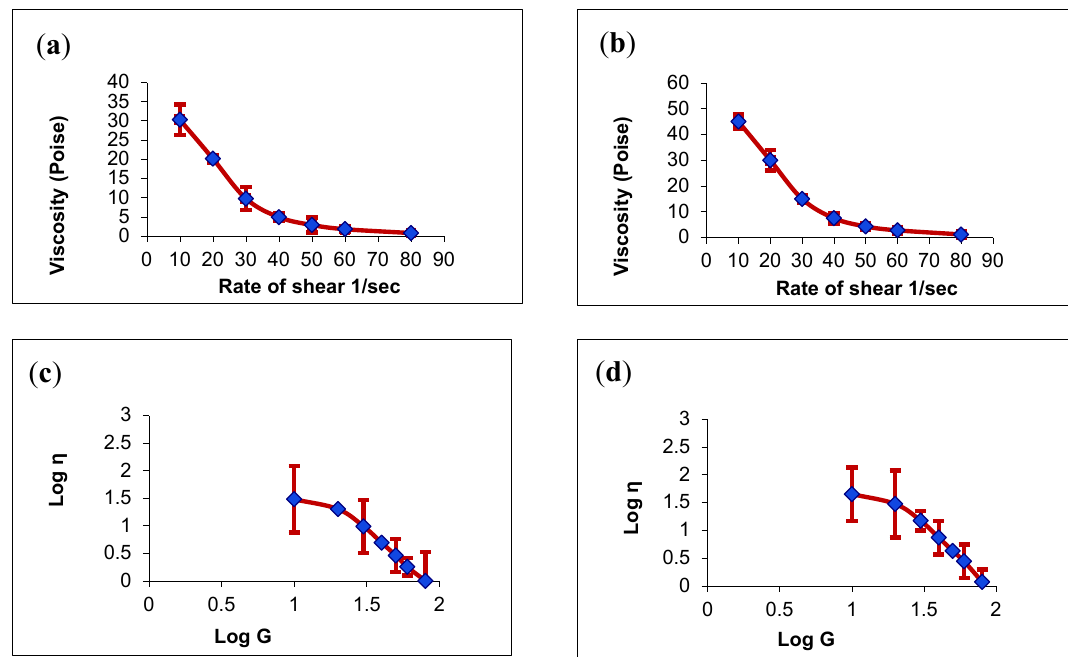
Figure 3. Plots of the shear rate (G) versus the viscosity ( η ) with a normal scale and with a logarithmic scale. ( a , c ) for plain hydroxypropyl cellulose (HPC) hydrogel (G4) and ( b , d ) for HPC hydrogel loaded with optimized CO-NE (NEG1). Values are expressed as the mean ± SD ( n = 3).